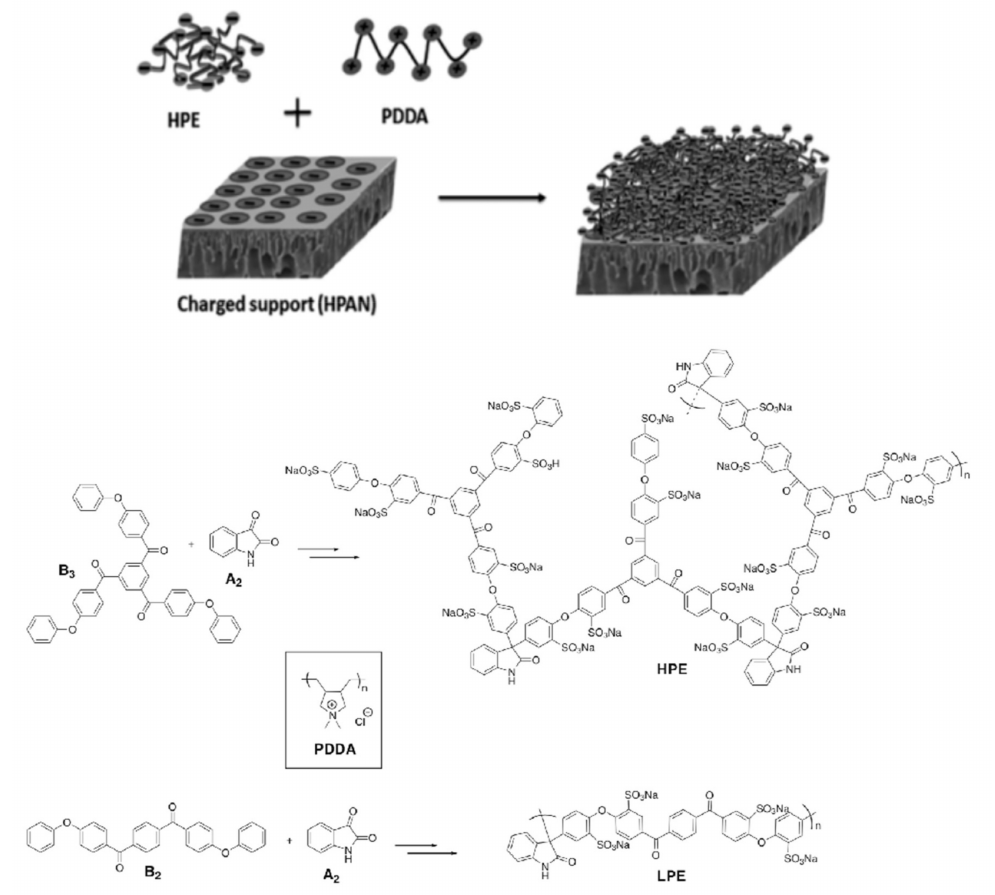
Figure 12. Schematic representation of the LBL preparation of a PEMM based on a linear cationic polymer (PDDA) and an anionic hyperbranched polyelectrolyte (HPE) sulfonated poly(aryleneoxindole) on a negatively charged support (hydrolyzed-polyacrylonitrile). Reproduced with permission from Reference